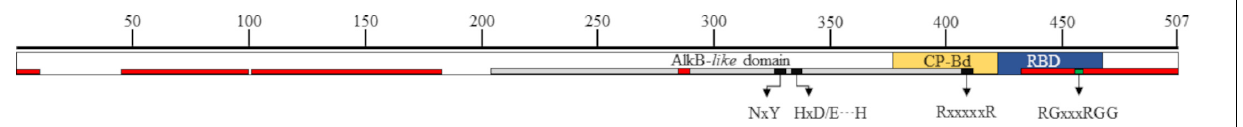
FIGURE 7 | at ALKBH9B multi-domain structure. Predicted IDRs, between positions 1–12, 48–101, 104–187, 280–288, and 437–507, are shown in red. AlkB- like domain, located at 216–411, is shown in gray. Black boxes in the AlkB- like domain delimit the 2-OG stabilizing motif (NxY: 324–326), motif involved in binding to iron -Fe II- (HxD/E ··· H: 335–340) and the substrate specificity motif (RxxxxxR: 335–411) [Alignment between the at ALKBH9B and hs ALKBH5 proteins, using the BLAST tool]. The AMV CP binding domain (CP-bd: 387–427) and RNA binding domain (RBD: 427–467) are shown in yellow and blue. RGxxxRGG motif between positions 469 and 465 within the RBD characterized here is shown in